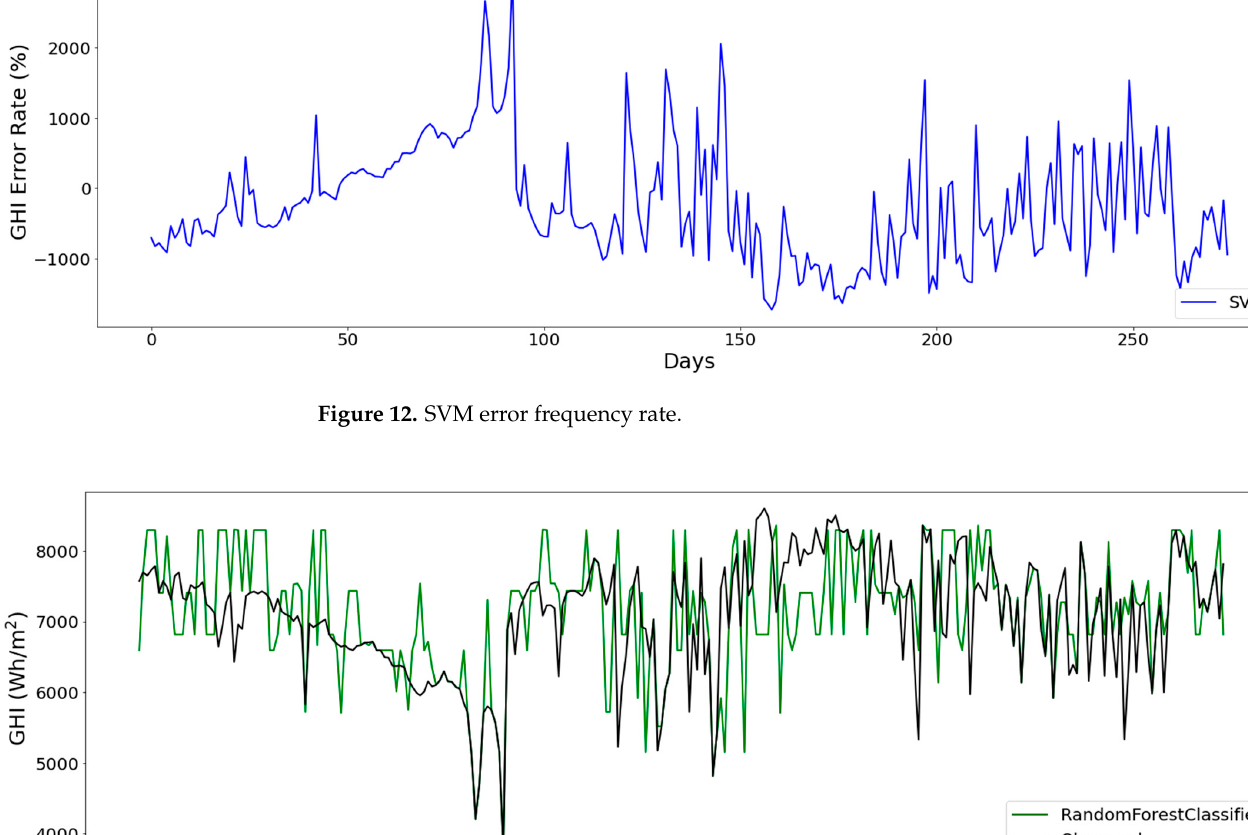
Figure 11. Graphical representation of SVM predictions.